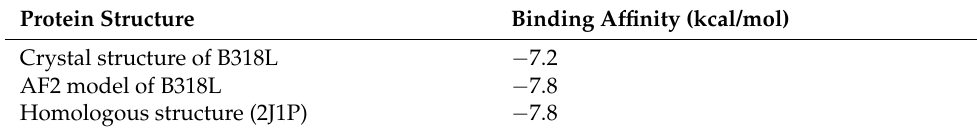
Table 2. The binding affinity values for three different structures in complex with GGPP.